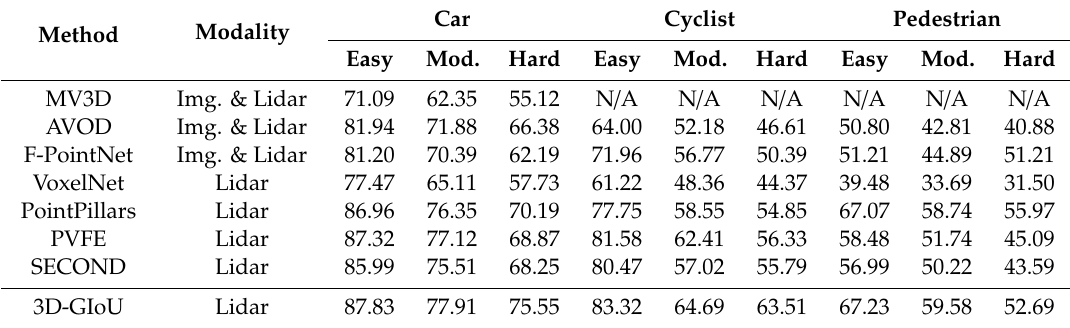
Table 2. Bird’s Eye View (BEV) detection performance: AP (%) for BEV box in the KITTI valuation set. Table 1. 3D detection performance: Average precision (AP) (%) for 3D box in the KITTI valuation set. Method